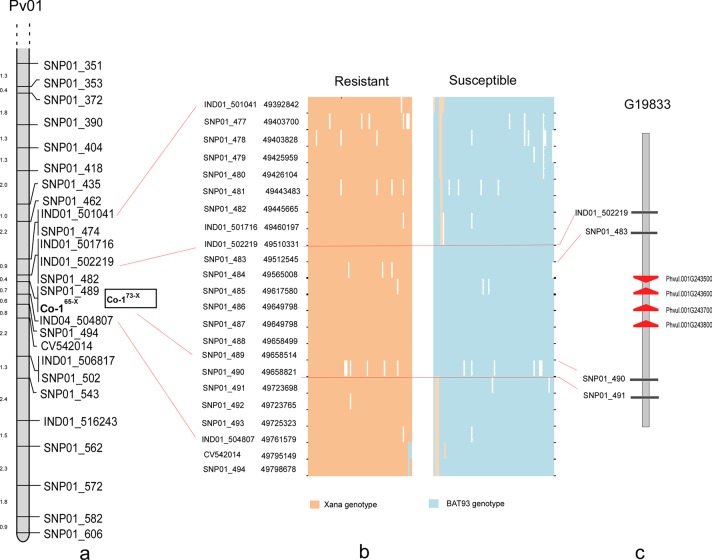
Genetic and physical mapping of the gene conferring resistance to race 65 in the end of linkage group Pv01.A) Fine map obtained for the end of linkage group Pv01 in the XB population. Numbers to the left represent cM distances between markers. B) Graphical representation of genotype observed into the flanked region by SNP01_482 and IND01_504807 based on the physical position of informative (mapped) and redundant SNP markers (non recombination with mapped markers). White gaps represents missing data. C) Genes related with the reaction to biotic stresses annotated in the candidate region for the resistance gene to race 65 (Co-165-X) in the G19833 genome.